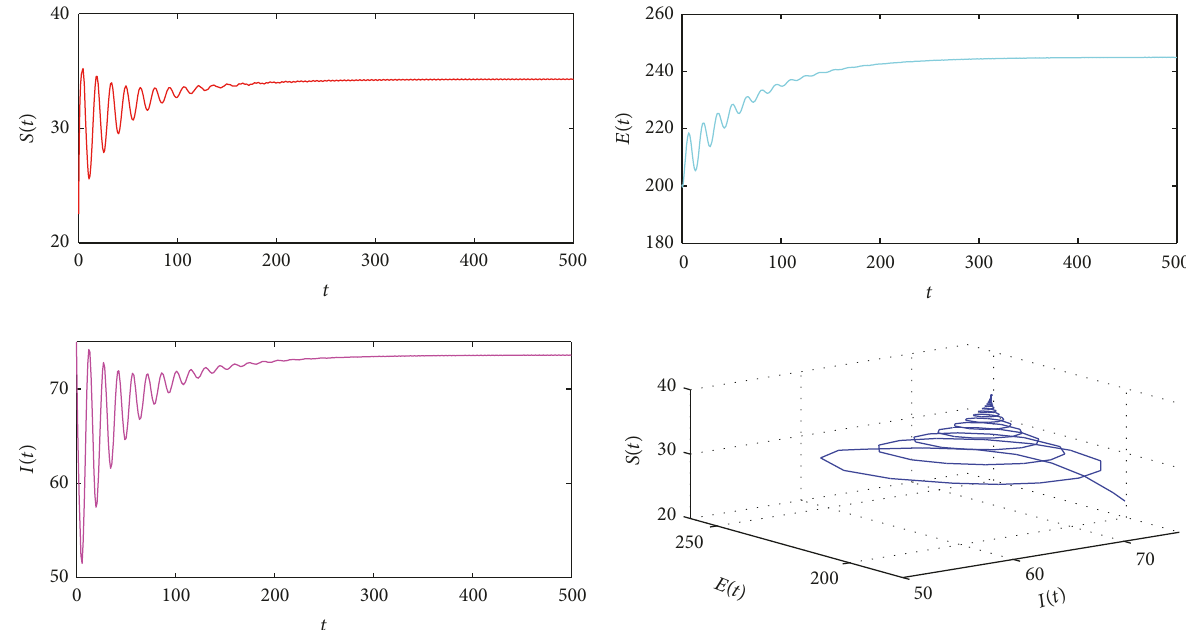
Figure 2: 𝑃 ∗ is locally asymptotically stable for 𝜏 = 4.475 < 𝜏 0 = 5.1686 with initial values “22, 200, 75.”